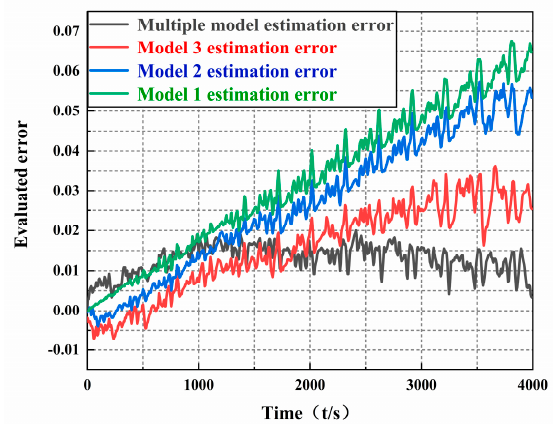
Figure 13. Multi-model and single-model SOC estimation errors.